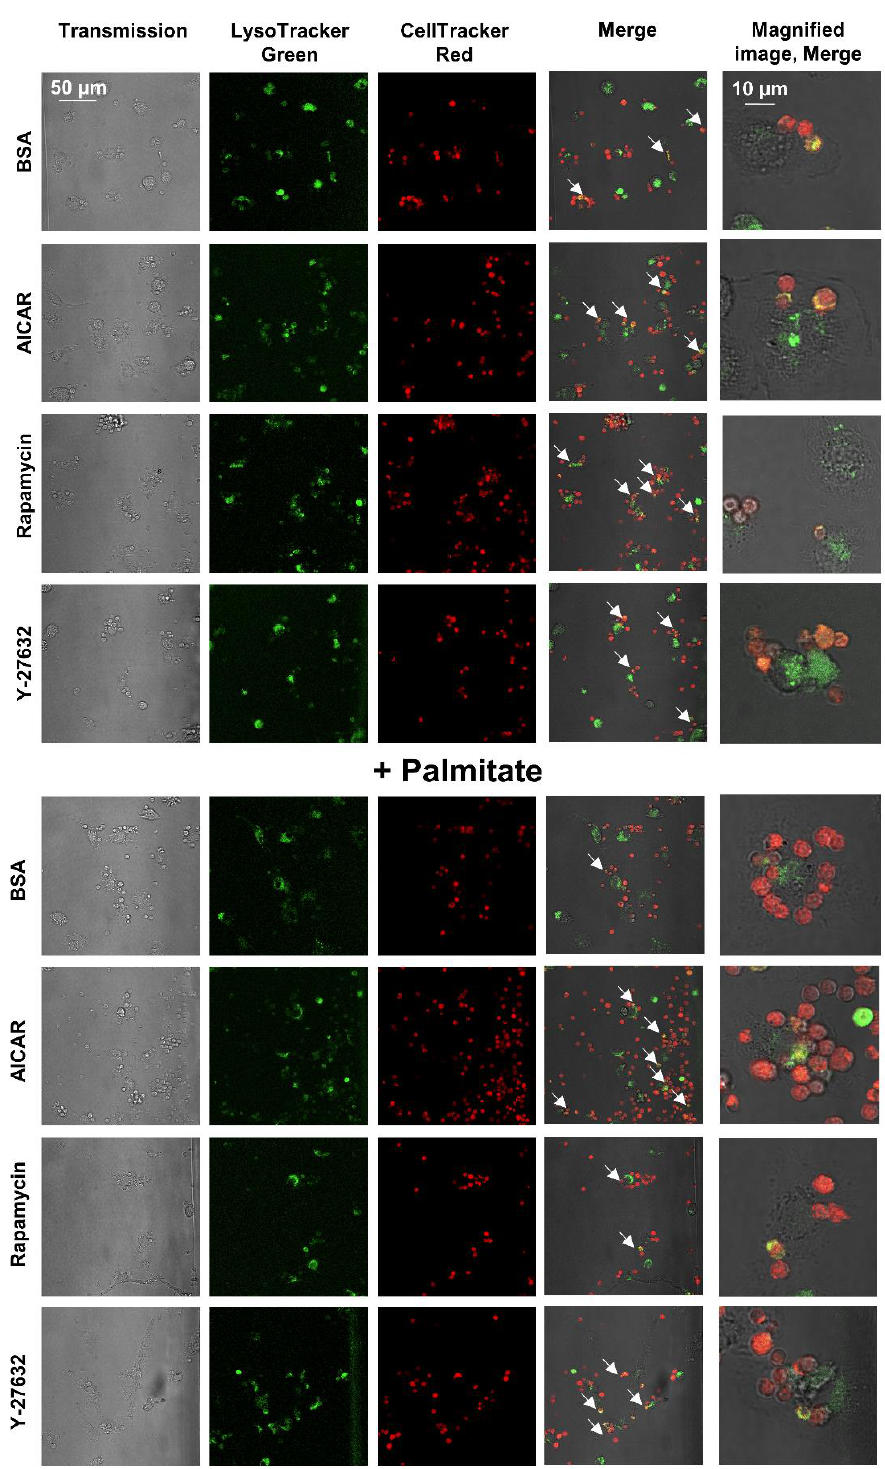
Figure 6. Delayed appearance of apoptotic cells in the phagolysosomes of BMDMs triggered by 24-h palmitate exposure is reverted by administration of AICAR, rapamycin, or Y-27632. Appearance of Deep Red Dye-stained red apoptotic thymocytes in the LysoTracker TM Green-stained green phagolysosomes of BMDMs exposed to palmitate (0.4 mM) for 24 h alone or together with rapamycin (100 nM), AICAR (0.5 mM), or Y-27632 (30 µ M) detected with confocal microscopy. Yellow/orange colors (arrows) indicate apoptotic cells appearing in the phagolysosomes following fusion of phago- somes with